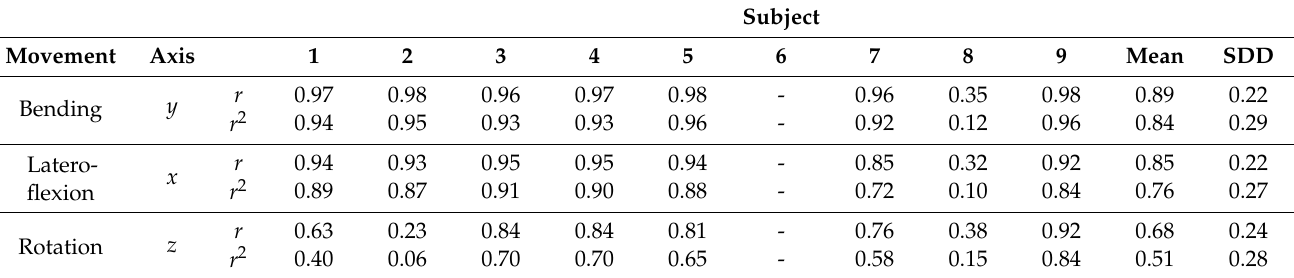
Table 2. ANN-based method performance in handling known loads. Shown are the correlations between the net moment at L5/S1 estimated with the ANN-based method and with the LSM-based method. Correlation is represented by the Pearson correlation coefficient ( r ) and determination coefficient ( r 2 ) are shown only for the axis of movement in each task (i.e., in the mediolateral axis ( y ) for the trunk bending tasks, in the anterior–posterior axis ( x ) for the lateroflexion tasks, and the longitudinal axis ( z ) for the rotation tasks, respectively. Shown are individual values for each subject plus the mean and standard deviation (SDD) over all subjects. No valid data were obtained for subject number 6 for reasons of partially missing data in the 6 kg trial.